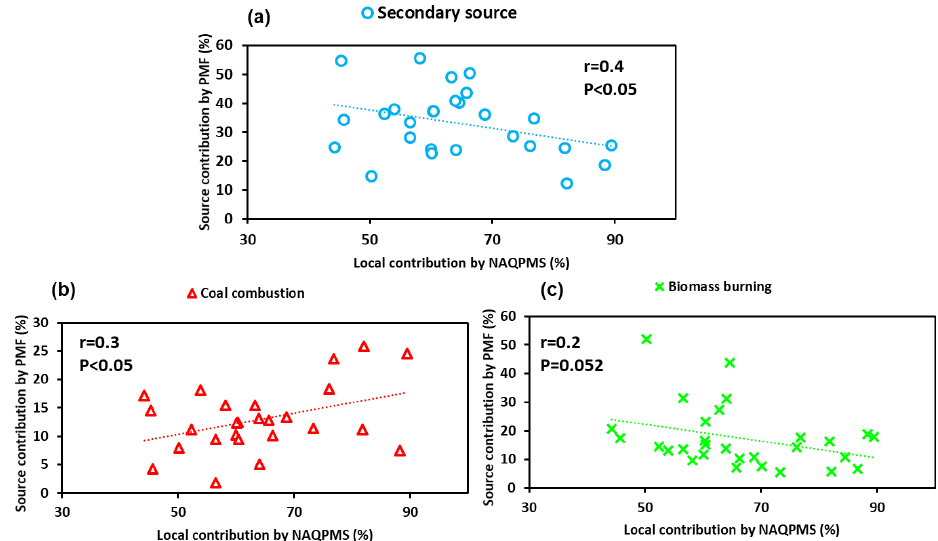
Figure 8. Correlations of local contribution by NAQPMS with the relative contribution by PMF of (a) secondary sources, (b) coal combustion sources and (c) biomass-burning sources.